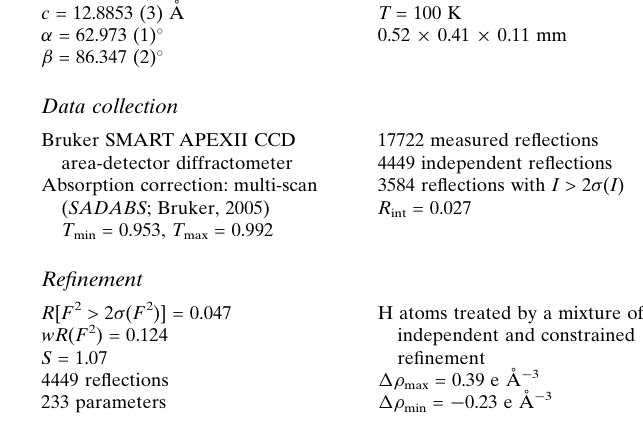
Bruker SMART APEXII CCD area-detector diffractometer